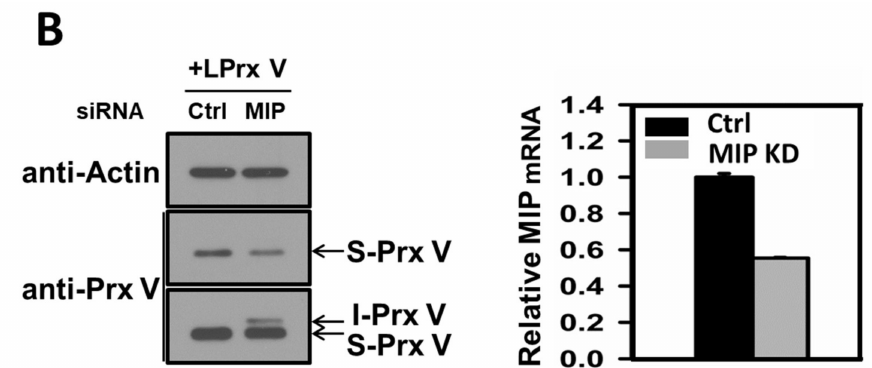
Figure 2. Maturation of L-Prx V involves I-Prx V that is cleaved by MIP. ( A ) Cell lysates of MEFs from wild type and Prx V KO mice as well as Prx V KO MEFs transfected with an expression vector for wild type L-Prx V, R40L L-Prx V, or F42G L-Prx V, were subjected to immunoblot analysis with antibody to Prx V. ( B ) HeLa cells were transfected with control scrambled or MIP siRNA using Oligofectamine. After 24 h, each cell was transfected again with an expression vector for LPrx V with Lipofectamine 2000 and harvested after 24 h. Cell lysates were subjected to immunoblot analysis with antibody to actin or Prx V (left panel). Two different blot exposures are shown for Prx V blot. Relative MIP mRNA levels were measured by quantitative PCR (right